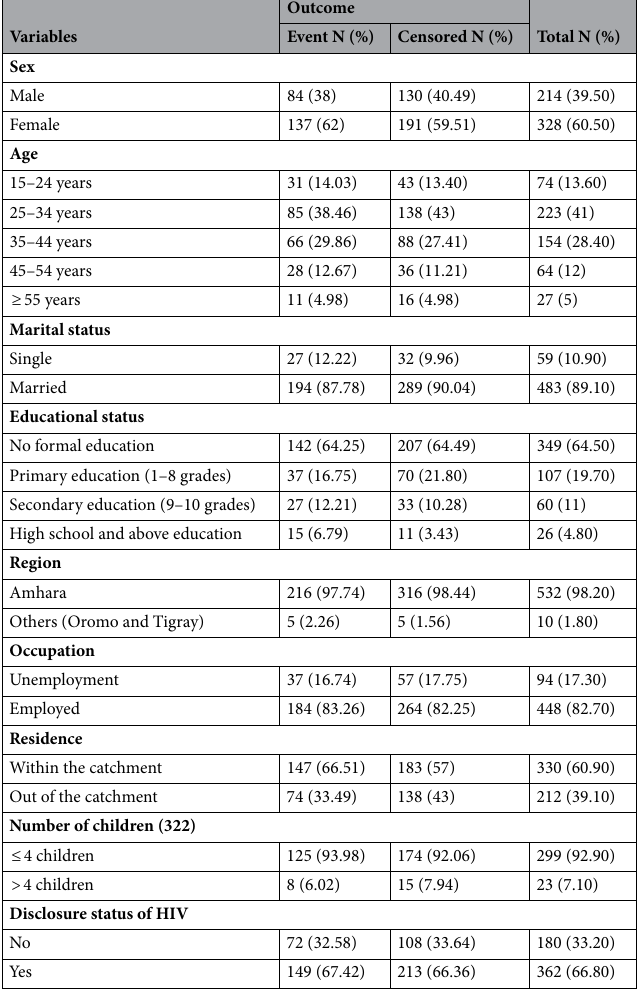
Table 1. Socio-demographic characteristic of adult HIV patients in Bichena health center, North West, Ethiopia, January 1, 2008–December 30,